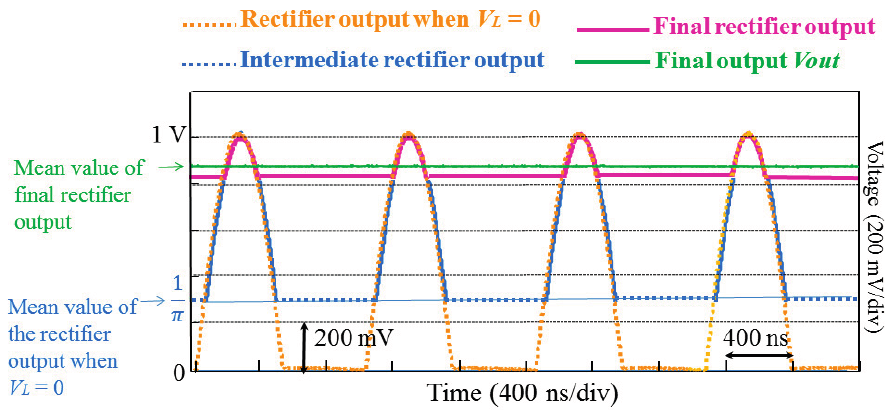
Figure 5. Operation principle of the rectifier with a feedback into the limiter V L . The brown curve was measured on an oscilloscope when V L = 0. The green curve was also measured in steady state when the filter output is re-injected to V L (circuitry of Figure 4). The blue and magenta curves were drawn and superimposed on the measured curves for illustration